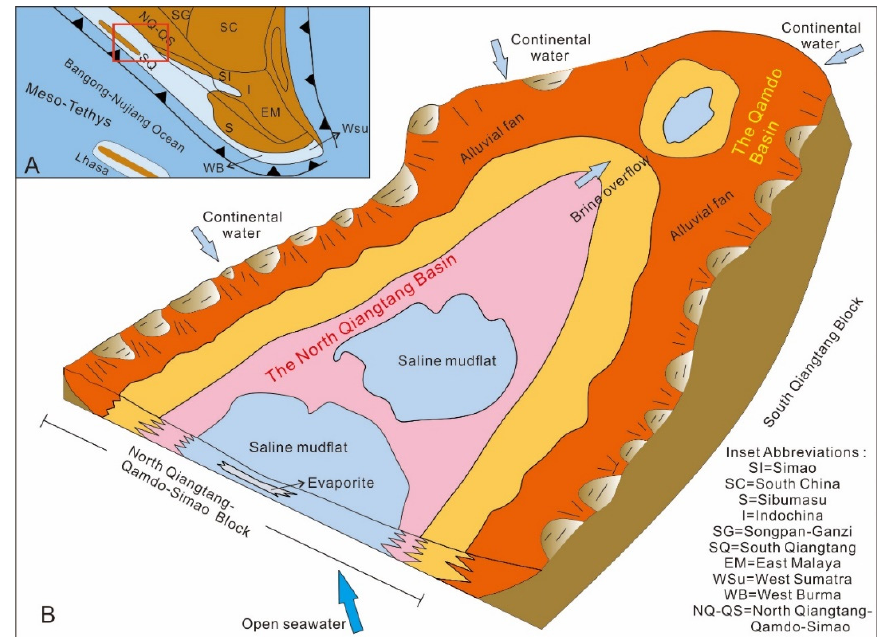
Figure 11. Palaeogeographic model of the Middle Jurassic sedimentation in Qamdo Basin and adjacent Qaingtang Basin. ( A ), Palaeogeographic reconstruction for eastern Tethys (Metcalfe, 2013); ( B ), Discharge model for Qamdo and Qiangtang Basins.